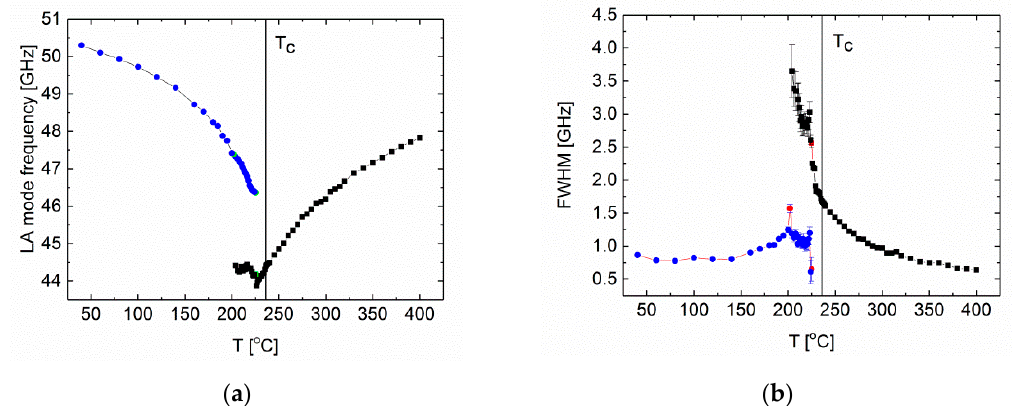
Figure 8. Temperature dependence of ( a ) the LA mode frequency shift and ( b ) the half-width of this mode, determined from the Brillouin light scattering [35].